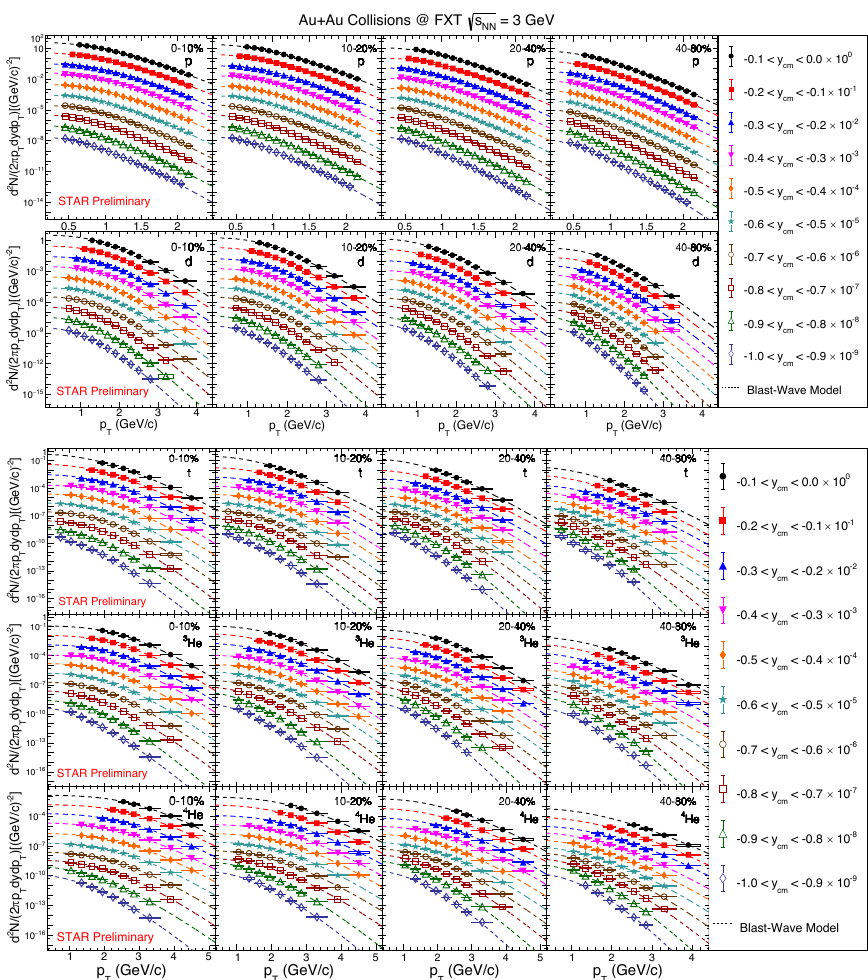
Figure 1: Transverse momentum spectra for proton, deuteron, triton, 3 He, and 4 He (cid:112) = 3 GeV. The dashed lines are fit by blast-wave s in Au + Au collisions at NN